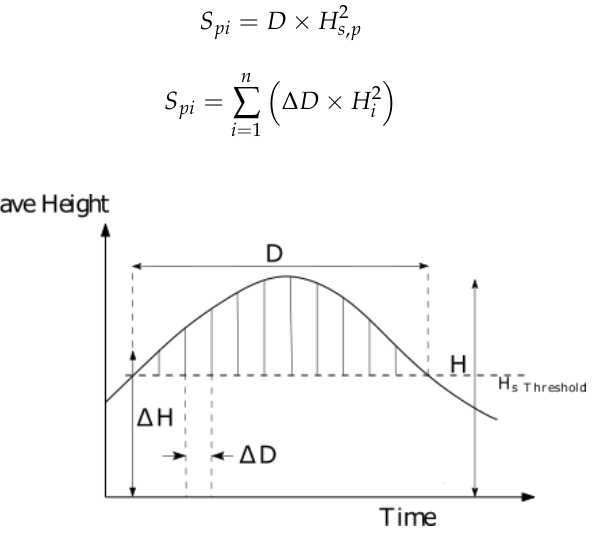
Figure 4. Schematic representation of storm power index using Equation (4) [31].